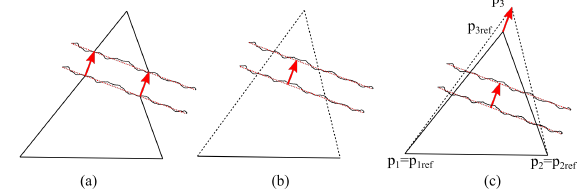
Figure 8. (a): crack through the reference triangle; (b): new triangle in the deformed state; (c): both triangles, where the edges (cid:126)s 12 and (cid:126)s 12 ref in reference and deformed state are